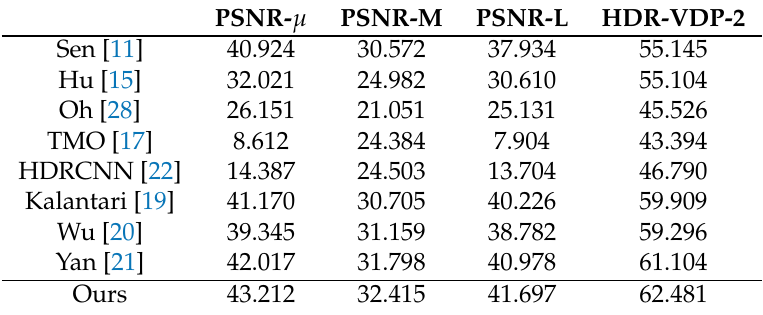
Table 2. Quantitative comparisons of the proposed method with state-of-the-art methods on [19], where bold indicates the best